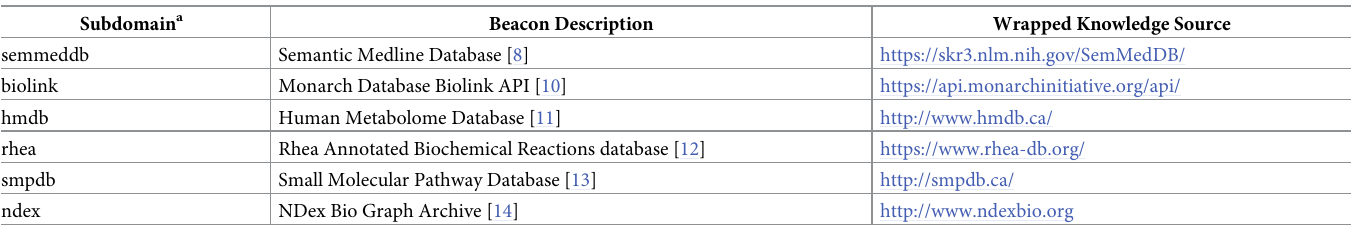
Table 1. Biomedical translator consortium deployed